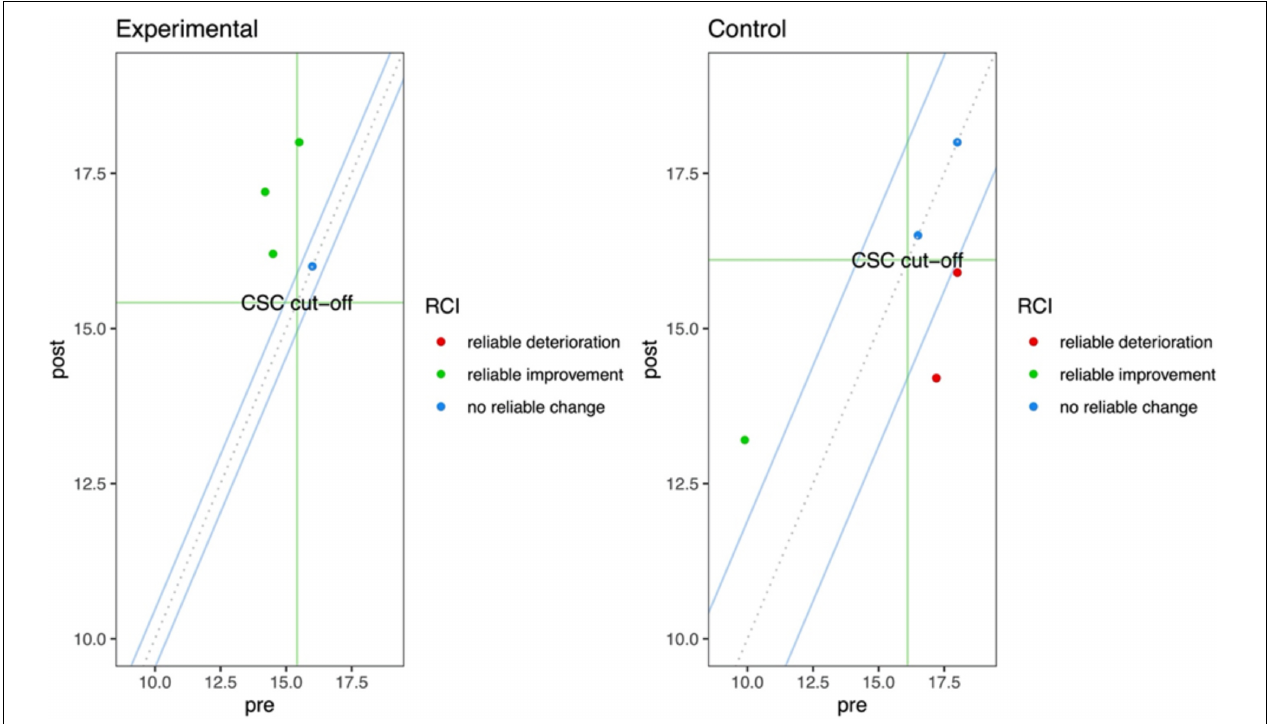
FIGURE 4 | Jacobson-Truax plot shows the RCI 95%CI (blue lines) and the CSC cut-off (green lines). The upper-left rectangle delimited by the green CSC lines shows the area of significant clinical change. The upper-right and lower-left rectangles delimited by the green csc lines show they are of RCI without a